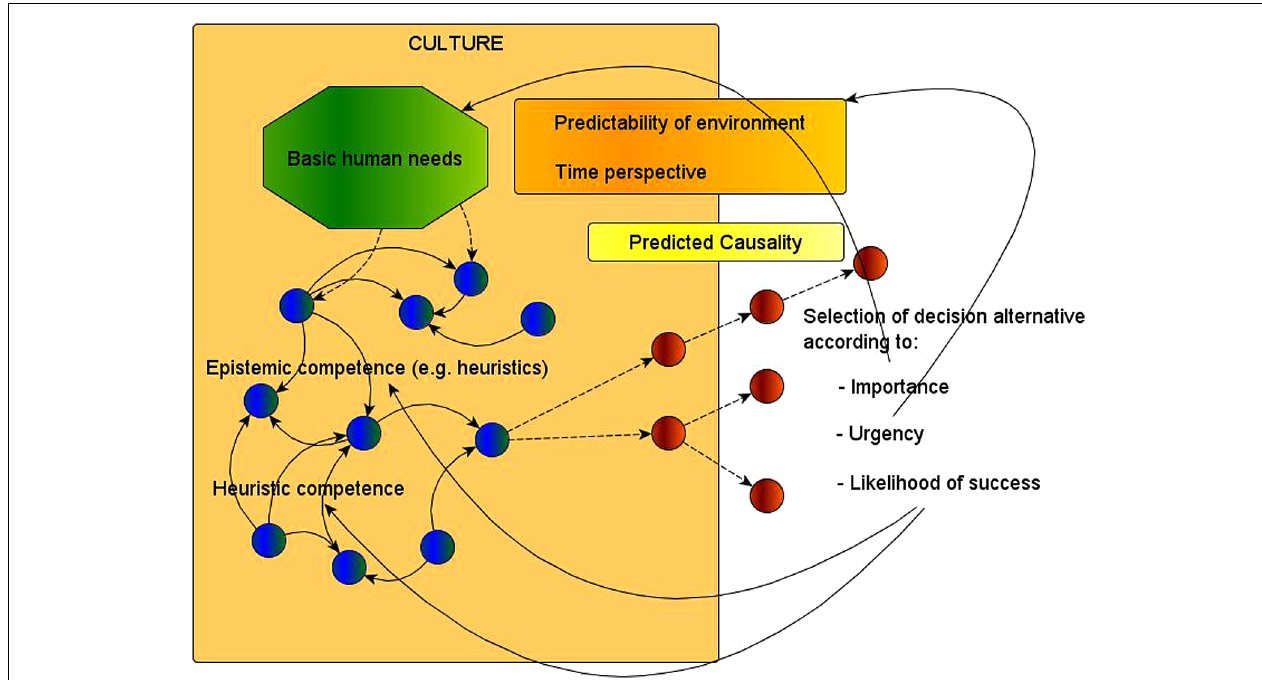
one decision alternative then depends on importance, urgency, and likelihood of success. Importance refers to the strength of a specific need. Urgency refers to predicted time needed to execute a decision. Likelihood of success refers to existing knowledge, i.e., epistemic competence, and heuristic competence, i.e., the estimation of one’s abilities to deal successfully with the current situation. Cultures differ regarding importance, urgency, likelihood of success, and predicted causal